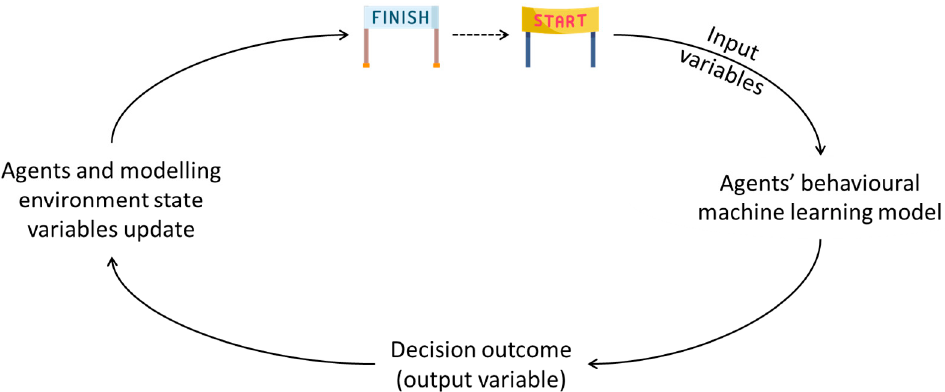
Figure 2. Flowchart of a basic timestep of the proposed data-driven agent-based models framework.